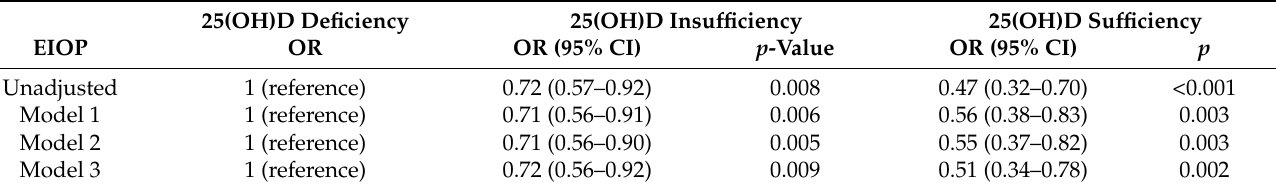
Table 2. Relationship between 25(OH)D status and EIOP.